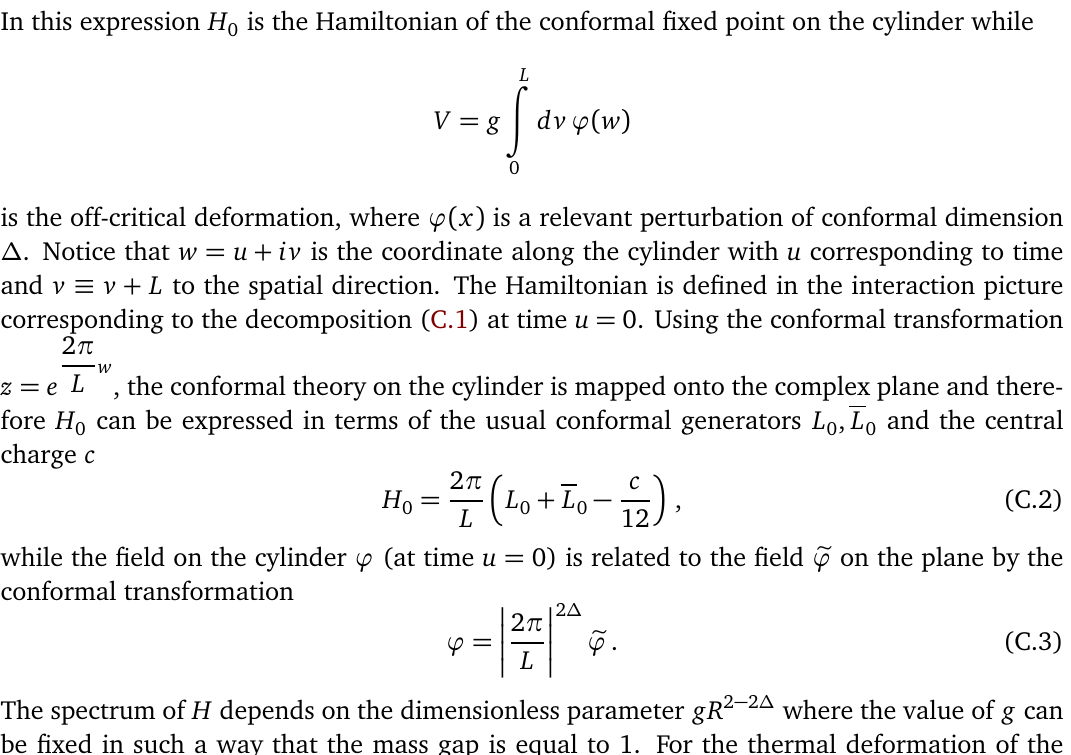
Table B.2: Three-particle couplings Γ